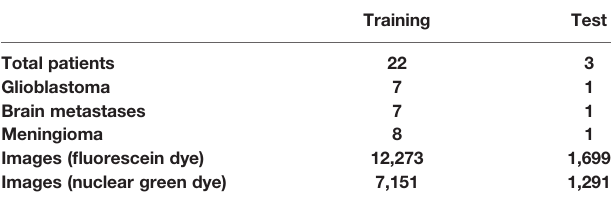
TABLE 1 | Patients ’ characteristics and data